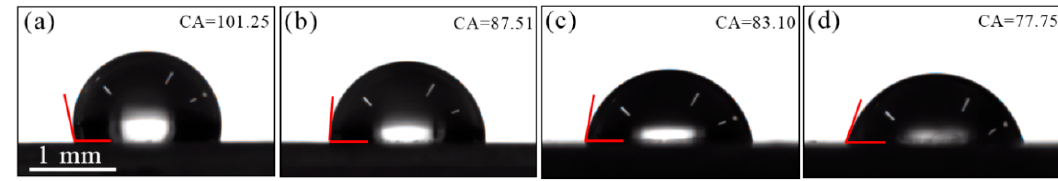
Figure 17. The contact angle of 4 μ L water droplets on the TCP-treated Zn55Al sheets with different immersion periods: ( a ) 0 s; ( b ) 30 s; ( c ) 60 s and ( d ) 180 s.